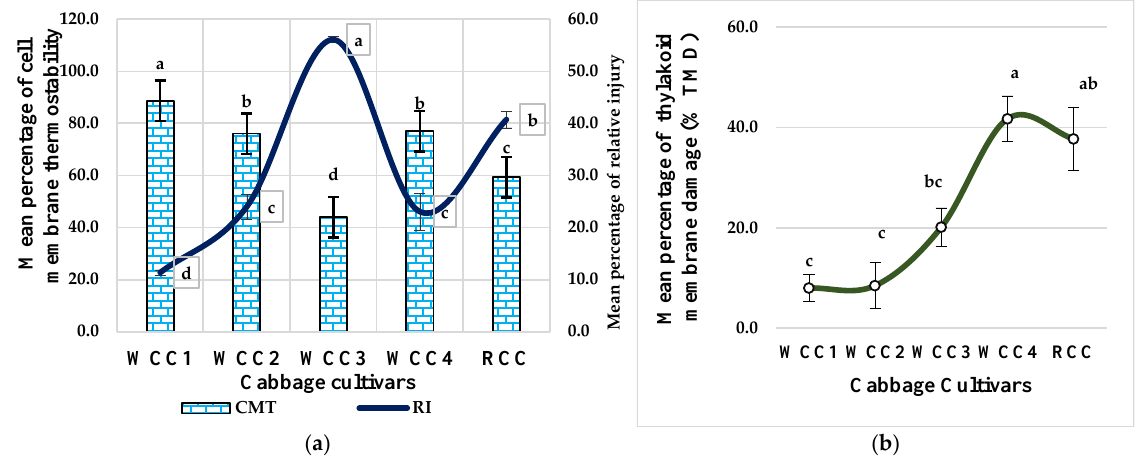
Figure 5. ( a ) Cell membrane thermostability (CMT) index and relative injury as determined by CMT and ( b ) mean percentage of damage to thylakoid membrane of in five cabbage cultivars measured under HS (at 42 °C; for 5 h) and NS (25 °C) conditions. Bars denote the mean of at least 5 measurements ± SE ( n = 5). Mean values within each cultivar with different letters are significantly different based on Tukey’s HSD test at p < 0.05.